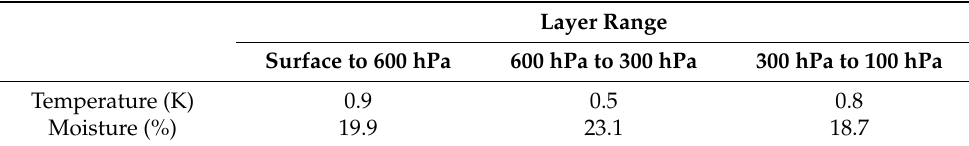
Table 6. The RMSE and bias of the temperature and relative humidity between the retrieval results and ERA5 data in three broad layers when the ERA5 data were used as the first